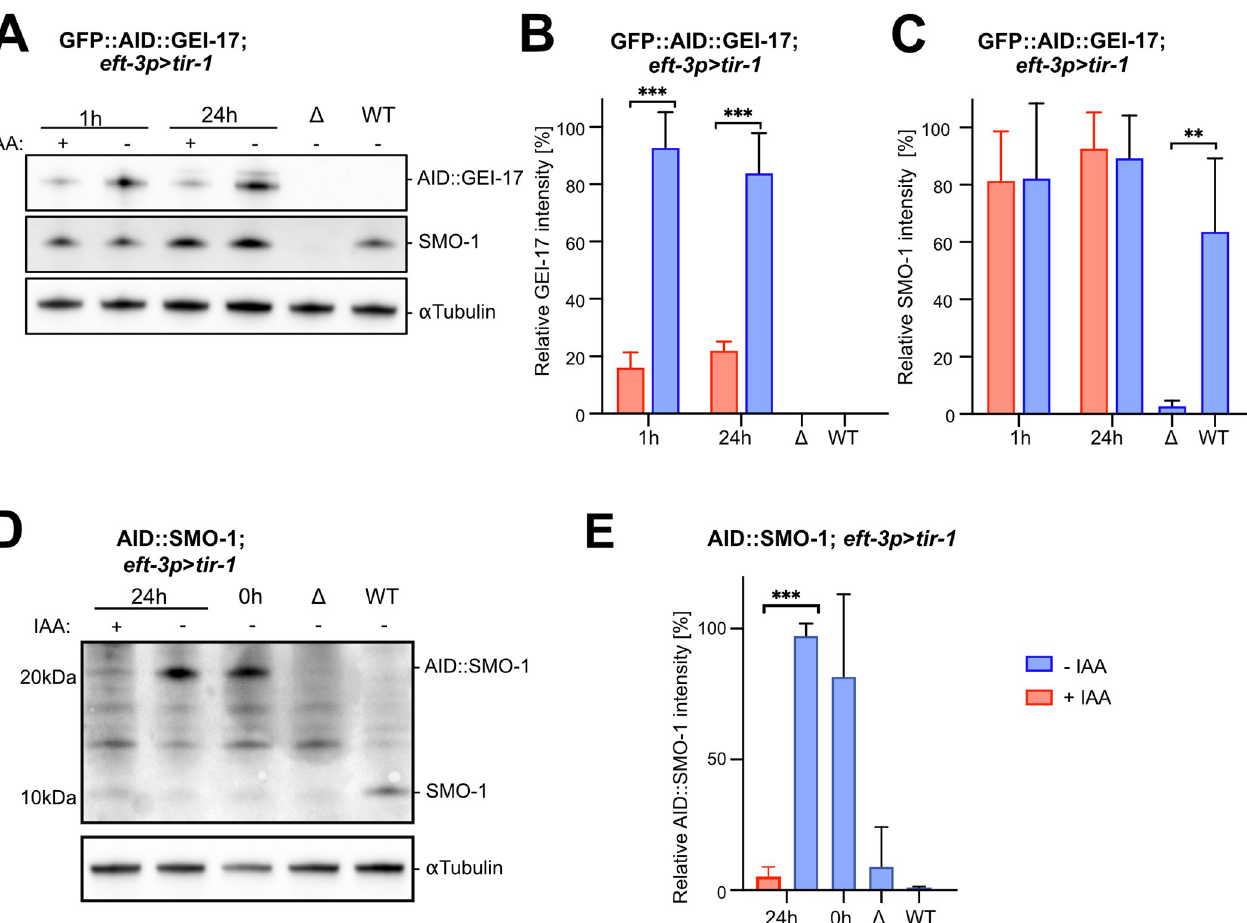
Fig 2. Degradation of AID-tagged GEI-17 and SMO-1. (A) Western blot analysis of GFP::AID::GEI-17 and free SMO-1 levels in one day-old adult animals carrying the eft-3p > tir-1 driver after 1 h and 24 h (from L4 until adulthood) auxin treatment (+IAA) and untreated controls (-IAA). The GFP::AID::GEI-17 protein was detected with an anti-FLAG antibody directed against a FLAG epitope co-inserted in the gei-17 locus. The SMO-1 protein was detected using an anti-SMO-1 antibody. Wild-type (WT) and a smo-1(ok359) deletion mutants ( Δ ) were included as controls. (B) Quantification of the GFP::AID::GEI-17 and (C) free SMO-1 protein levels in GFP::AID::GEI-17; eft-3p > tir-1 adults after 1 h and 24 h of auxin treatment and in untreated controls. ( D ) Western blot analysis of free AID::SMO-1 levels in one day-old adult animals carrying the eft-3p > tir-1 driver after 24 h (from L4 until adulthood) auxin treatment (+IAA) and untreated controls (-IAA). AID::SMO-1 and untagged SMO-1 were detected using an anti-SMO-1 antibody. WT and SMO-1 deletion mutants ( Δ ) were used as a controls. Note the untagged SMO-1 protein in the WT controls migrating around 10 kDa. ( E) Quantification of the AID::SMO-1 protein levels in the strains shown in ( D) . All graphs show the mean values ± SD obtained from three independent biological replicates. Signal intensities were first normalized to the α -tubulin signals as loading control and then to the highest value in each experiment. Untreated controls are labelled with–IAA (blue) and animals treated with 1 mM auxin with +IAA (red). Statistical significance was determined by Ordinary one-way ANOVA. p-values are indicted as � p � 0.05; �� p � 0.01; ��� p �